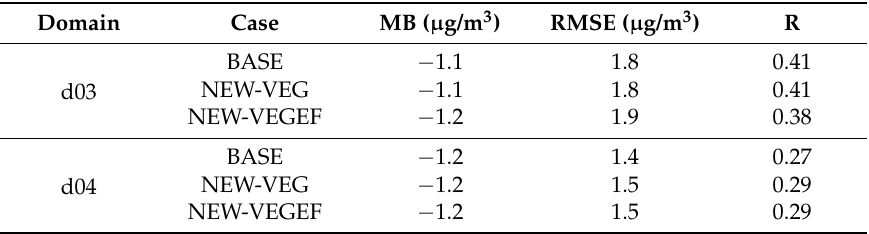
Table 5. Statistical analysis of model performance for daily surface OC concentrations during the monitoring campaign in d03 and